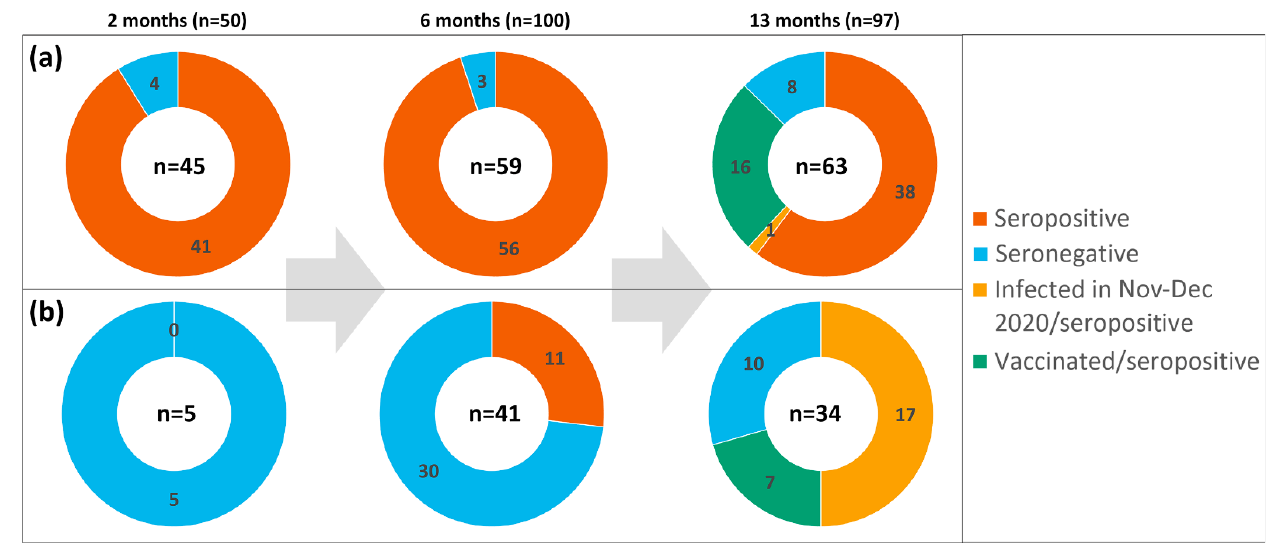
Figure 2. Seropositivity pattern in the groups of study participants tested as SARS-CoV-2-specific RT-PCR positive ( a ) and RT-PCR negative ( b ) during the outbreak in April 2020. On the top of each section, time after the outbreak and the number of study participants subjected to serologic testing are indicated. Table 3. Summarized results of the second serologic testing 6 months after the outbreak (20 October 2020). Total number of participants of the second serologic